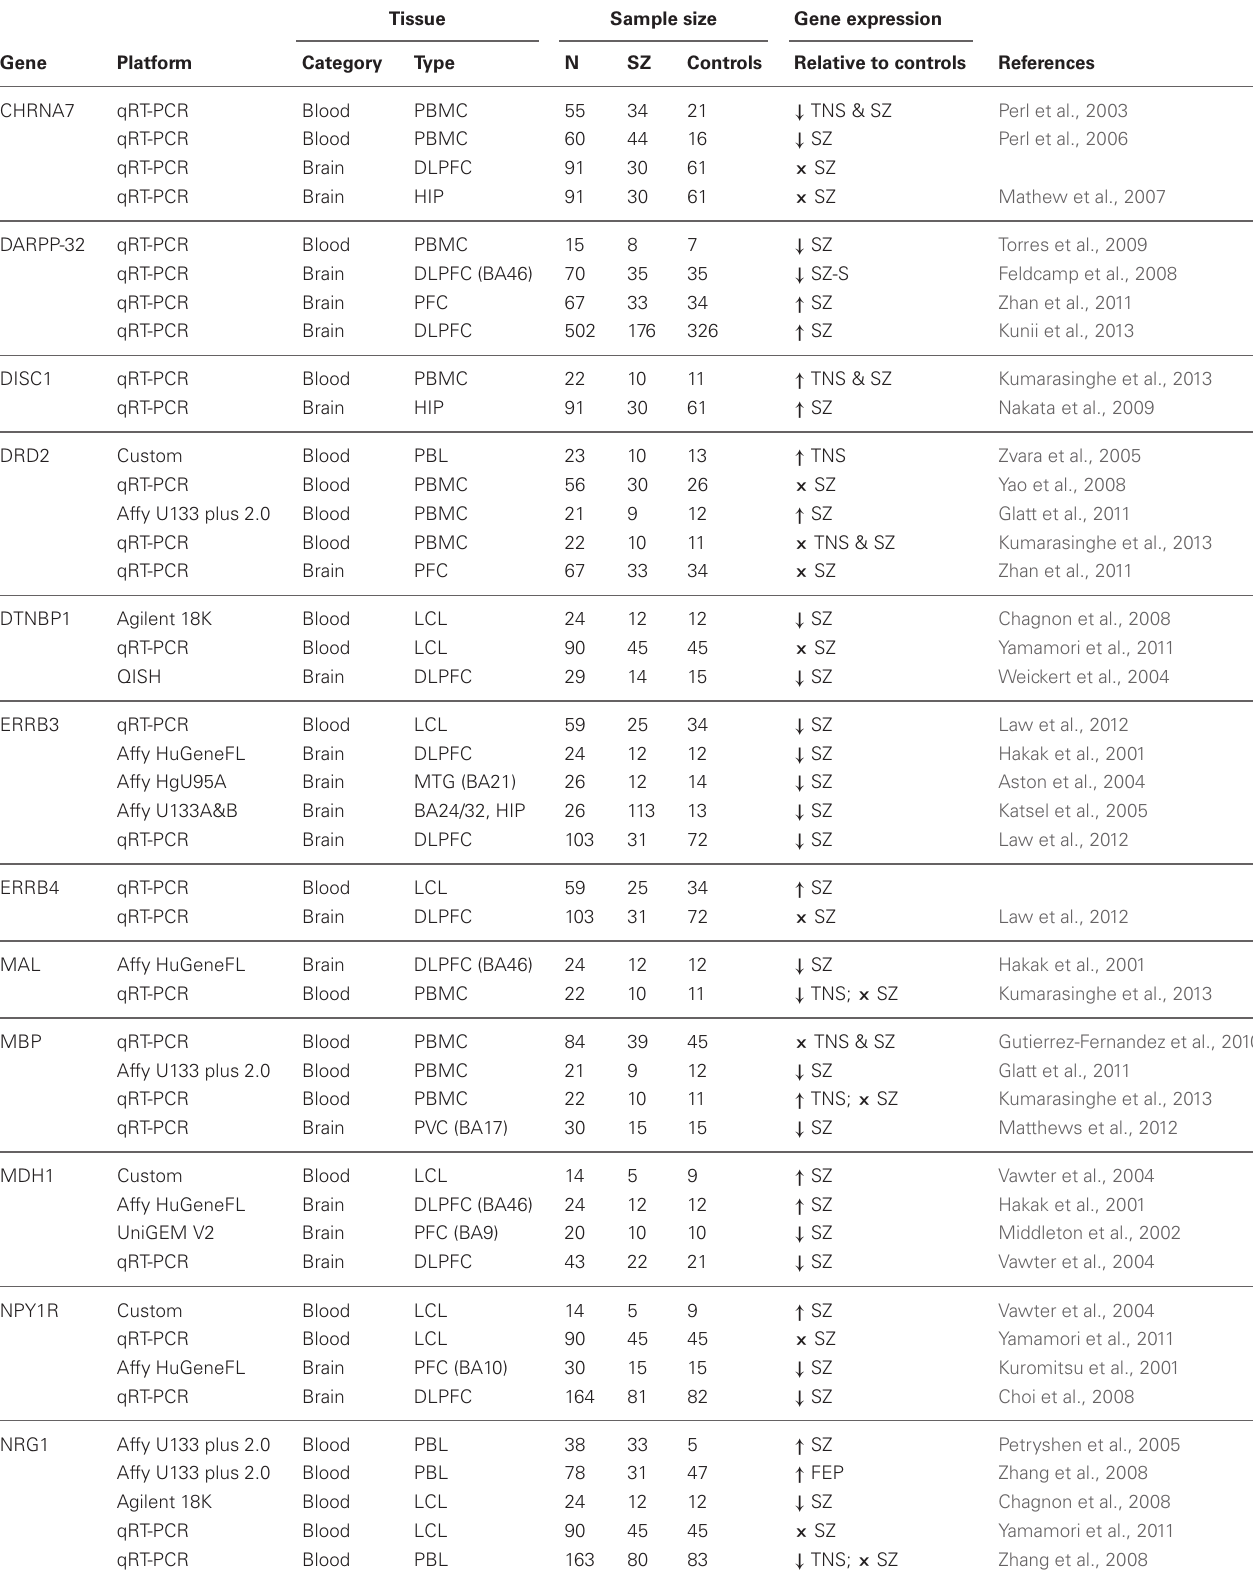
Table 1 | Gene expression biomarkers for schizophrenia in blood and brain. Tissue Sample size Gene